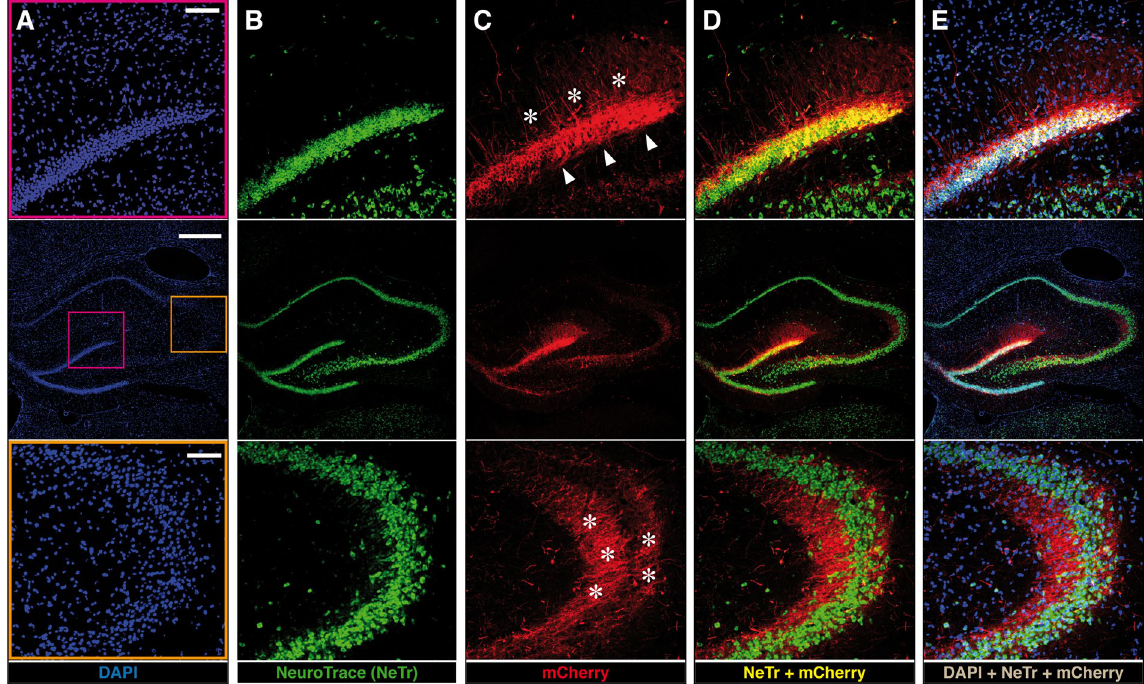
Figure 5. Localization of mCherry expression in the hippocampus. Representative images (5 sections/animal, 4 animals/group) taken from coronal sections prepared from animals killed 2 months after J Δ NI6 injection into the right hippocampus. Middle panels show low magnification images of the whole hippocampus; upper panels show higher magnifications of the dentate gyrus including the granular layer (site of granule cell somas), framed in pink in the middle panel A; lower panels show higher magnifications of the CA3 areas (site of the axon terminals originating from the granule cells), framed in orange in the middle panel A. ( A ) Nuclei, stained in blue with DAPI. ( B ) Nuclei of neurons, stained in green with neurotrace. ( C ) Native mCherry florescence (red). Arrowheads, mCherry signals in granule cell bodies; asterisks, mCherry signals in dendrites (upper panel) and axon terminals (lower panel). ( D ) Neurotrace and mCherry double-fluorescence. Note overlapping signal (yellow) in granule cells (upper panel) but not in CA3 pyramidal cells (lower panel). ( E ) DAPI, neurotrace and mCherry triple-fluorescence. Note overlapping signal (white) in granule cells (upper panel) but not in CA3 pyramidal cells (lower panel). Also note that non-neuronal cells (blue nuclei) do not express mCherry. Horizontal bar in ( A ) (middle panel), 500 μ m; horizontal bar in ( A ) (upper and lower panels), 100 μ